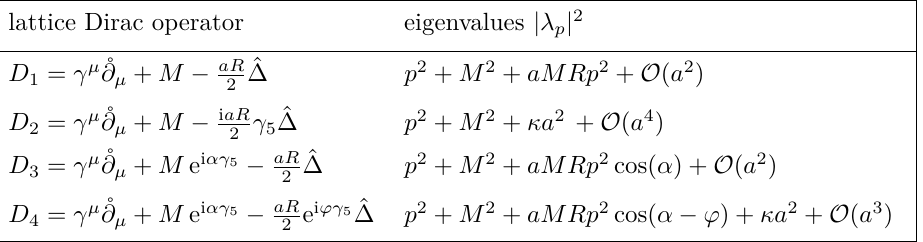
Table 4 . Eigenvalues | λ p | 2 of several lattice Dirac operators D i , expanded in powers of the